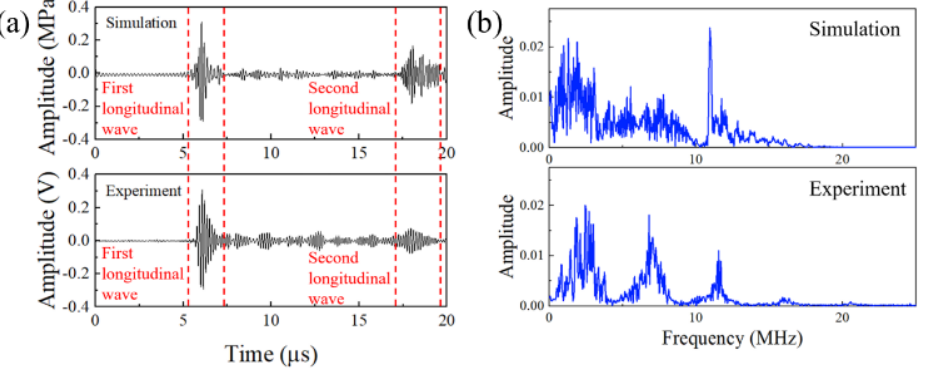
Figure 7. ( a ) Ultrasonic signals obtained from the simulation and the experiment; ( b ) FFT spectrum of the simulation and experiment’s ultrasonic signal.